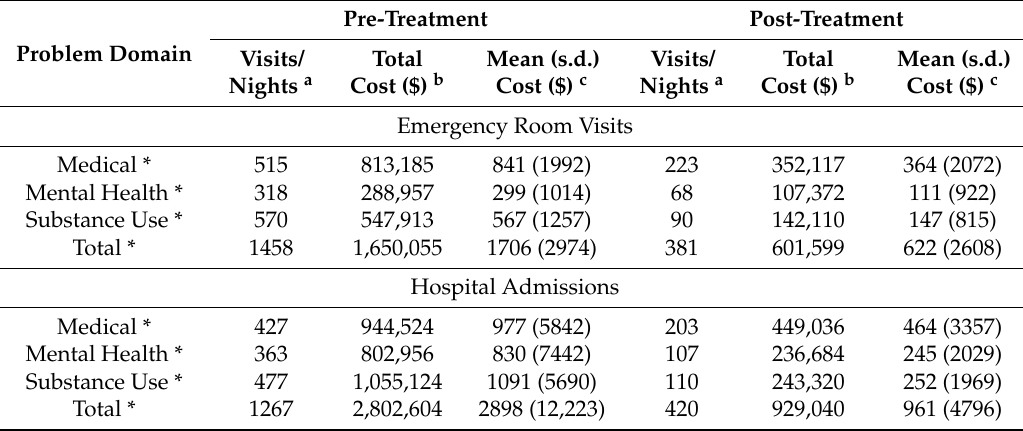
Table 2. Estimated costs of ER visits and inpatient nights, pre-treatment and post-treatment ( n =